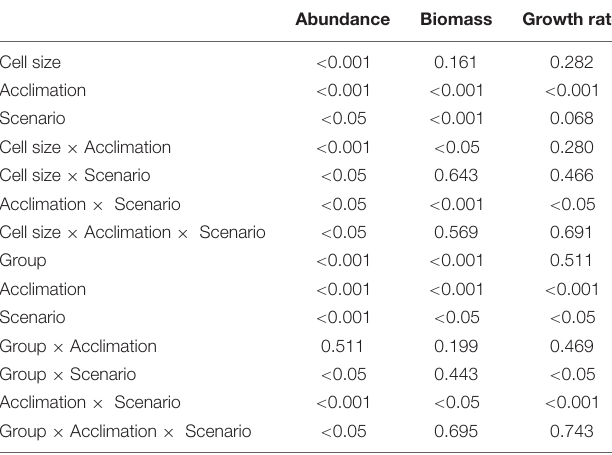
TABLE 4 | p -values of the three-way ANOVAs for phytoplankton abundance ( Figures 6A,B ), biomass ( Figures 6C,D ), and growth rates ( Figures 6E,F )